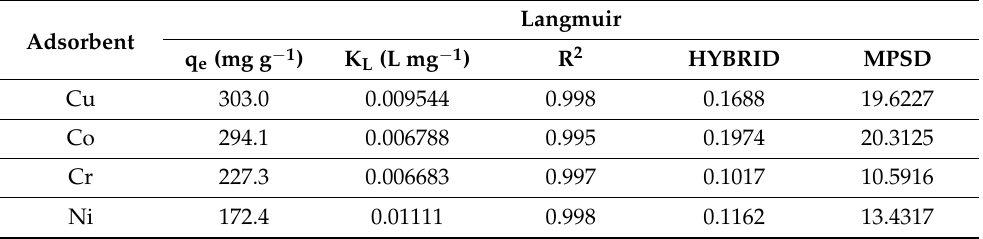
Table 5. Isotherm parameters and error functions for adsorption onto poly(amidoxime) ligand. Adsorbent